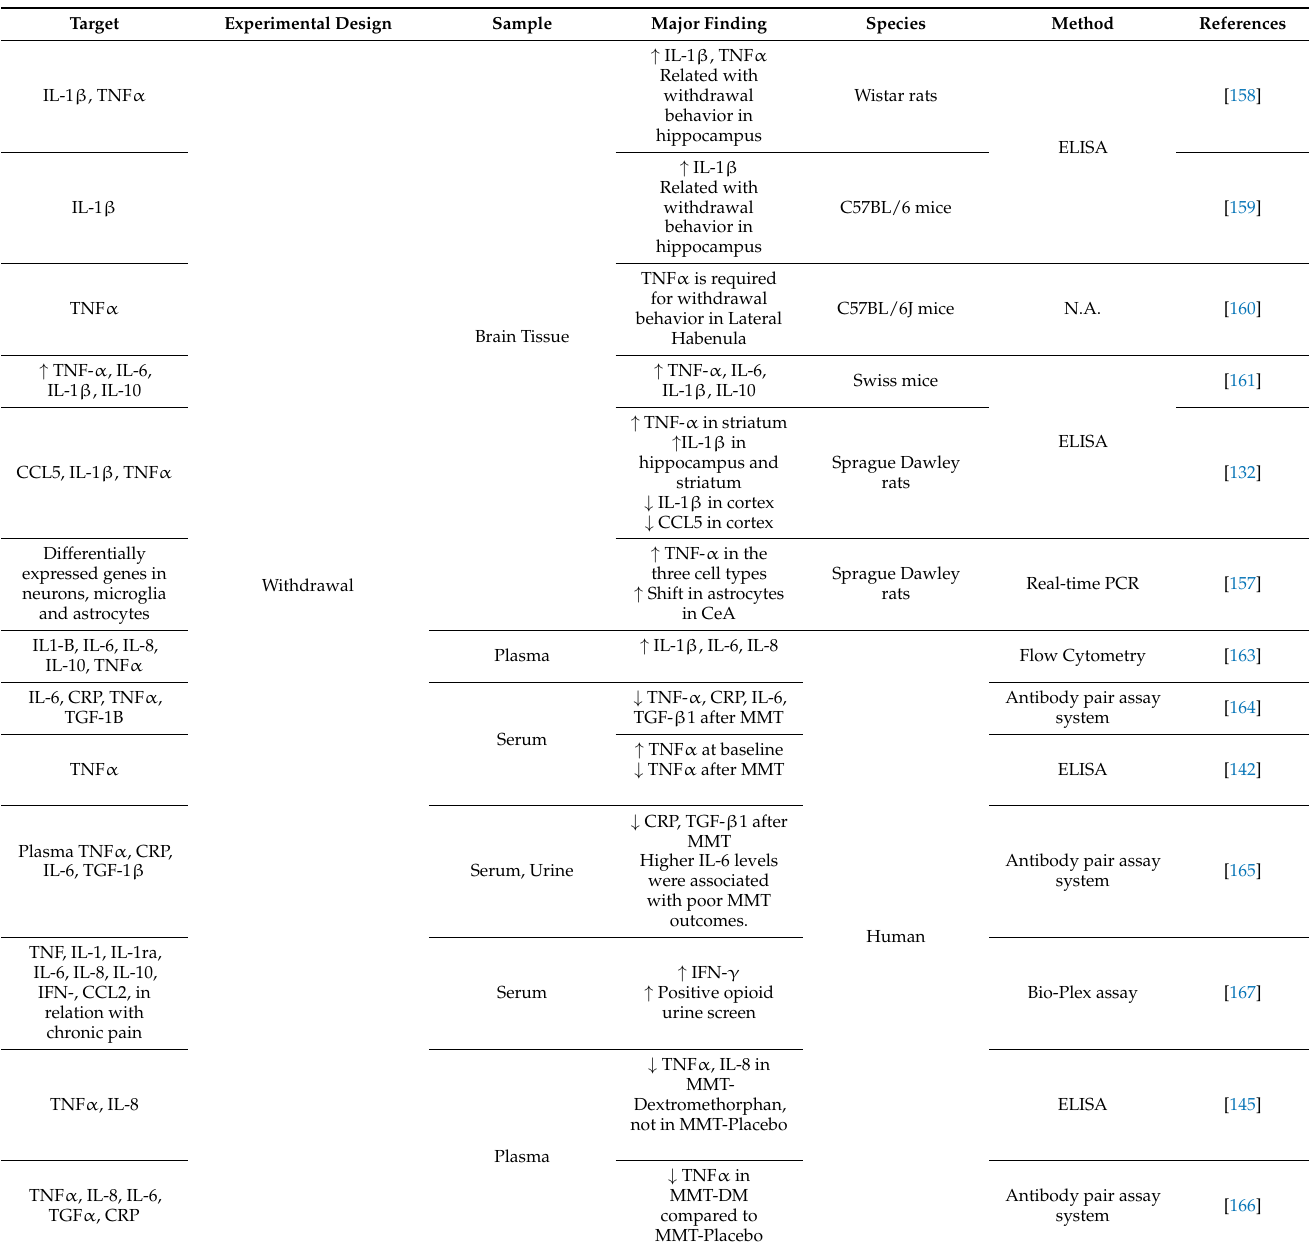
Table 8. Opioid Use Disorder: